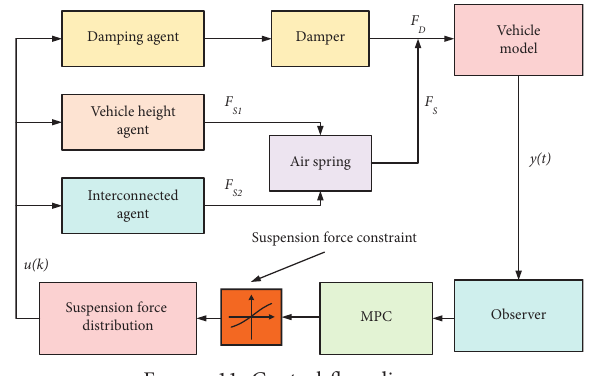
Figure 11: Control flow